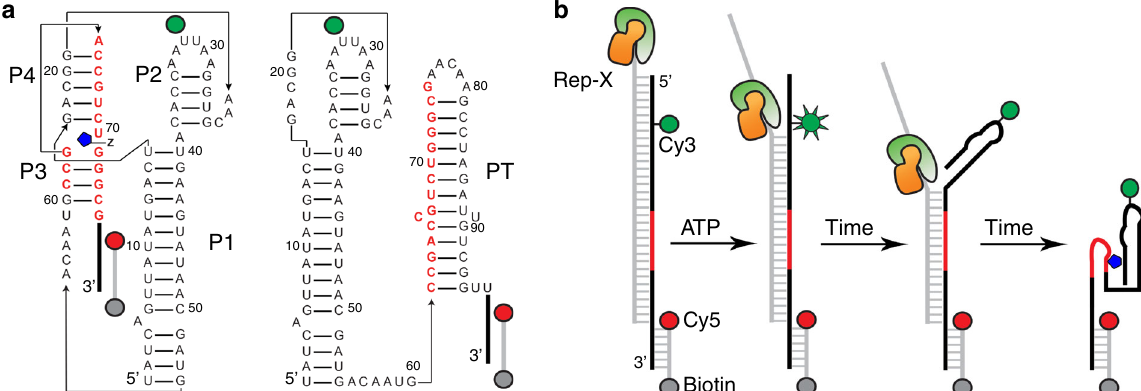
Fig. 1 ZTP riboswitch single-molecule FRET constructs. a The ZTP riboswitch aptamer ( Δ term, left) formed by paired elements P1-4 bound to ZMP (Z, blue). A Cy3 fl uorophore (green sphere) is attached to solvent accessible U32, and a Cy5 fl uorophore (red sphere) is placed at the 3 ′ -end of the DNA tether, which is also 5 ′ -end labeled with biotin (gray sphere) for attachment to the streptavidin-coated slide. In the full-length riboswitch (WT, right), the nucleotides colored in red switch between two conformations, one in which a terminator hairpin (PT) or terminator folds and the ligand is not bound. b Cartoon depicting the vectorial folding (VF) assay, in which an engineered helicase Rep-X (orange and green) releases the riboswitch RNA (black) in a 5 ′ -to-3 ′ direction by translocating on the cDNA strand (gray) and unwinding in a 3 ′ -to-5 ′ direction. During unwinding, when Rep-X is proximal to Cy3, a temporary increase in Cy3 fl uorescence [i.e., protein-induced fl uorescence enhancement (PIFE)] is